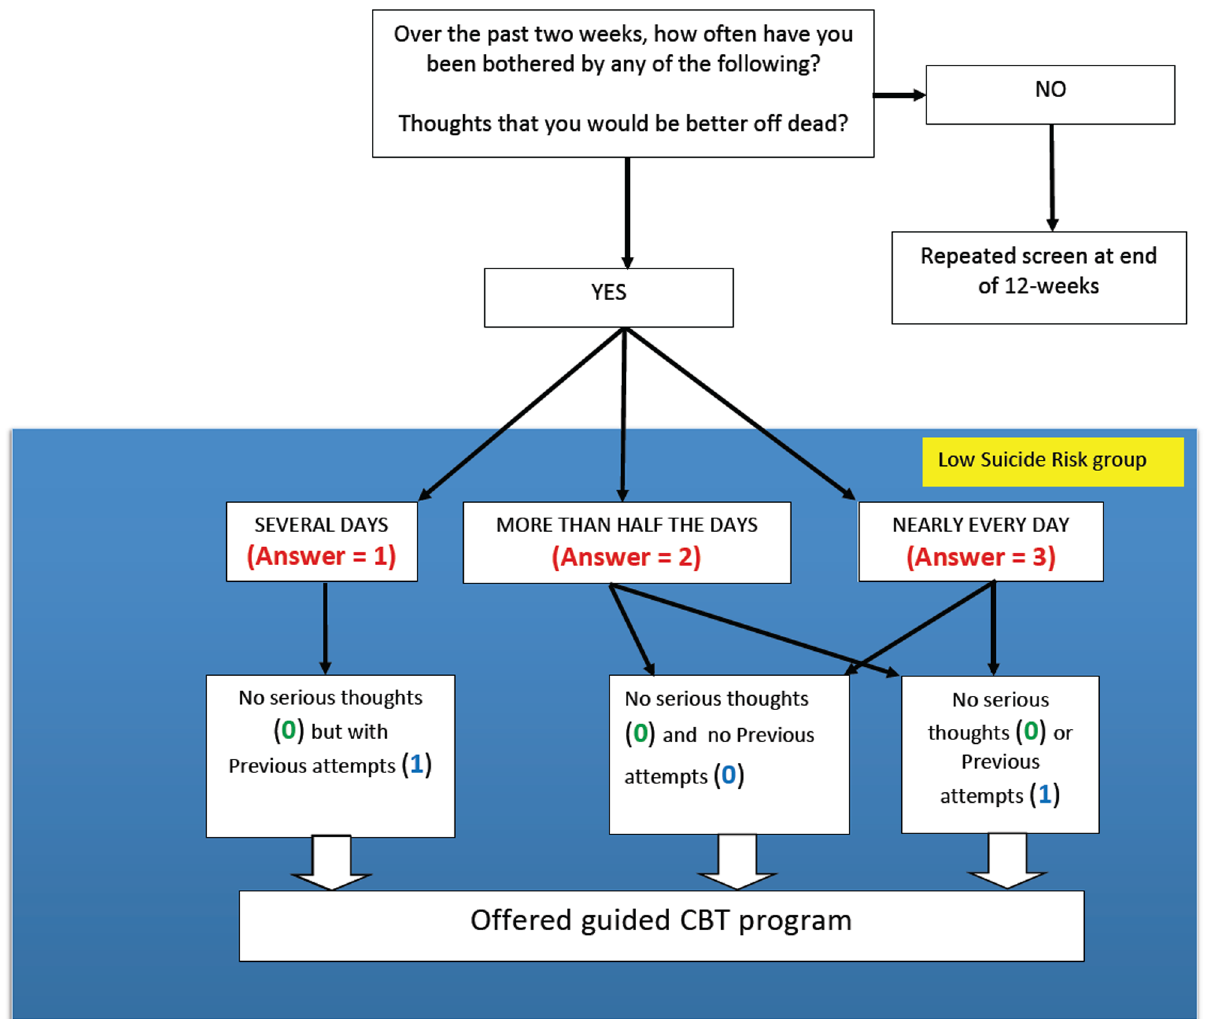
Fig 3. Algorithm for determining which students were in the “ low suicide risk ” group. The figure shows how scores on the three questions regarding thoughts of suicide determined if the student was in the low suicide risk group. These students were not interviewed individually, but were offered participation in a guided internet-based cognitive behavioural therapy (CBT)